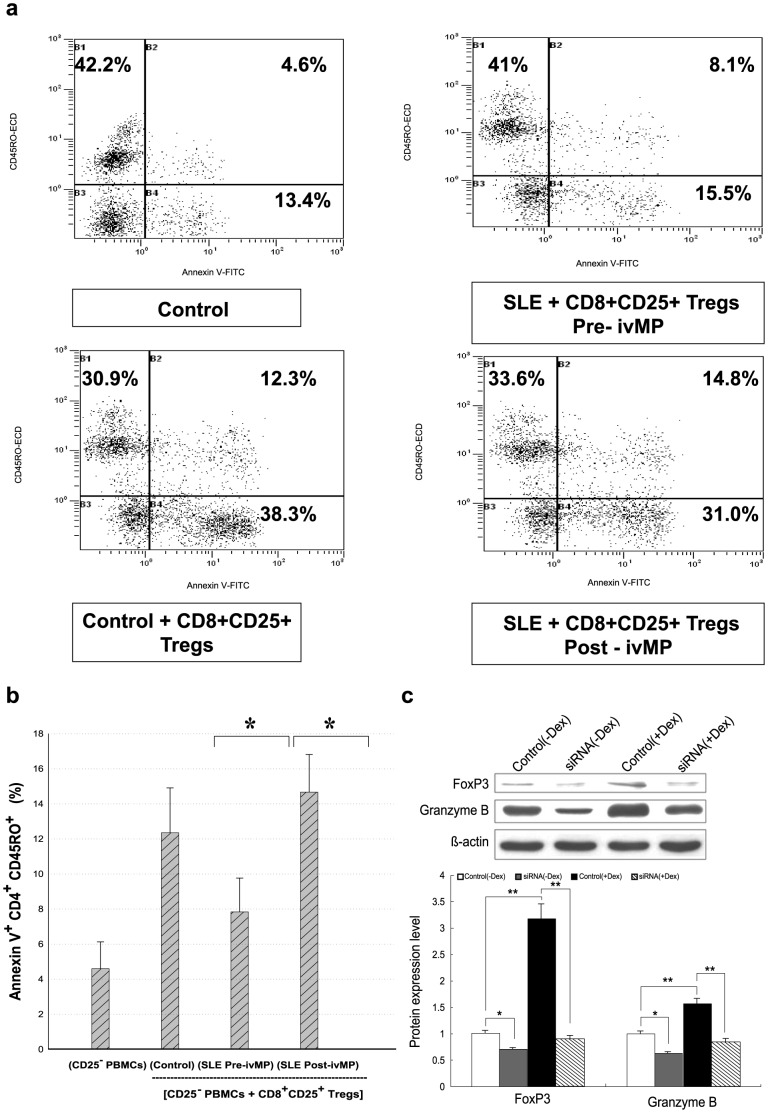
Double fluorescence study by flow cytometry of CD45RO lymphocytes subpopulations and apoptosis by CD8+CD25+ regulatory T cells during IVMP.(a). CD25+-depleted PBMCs were co-cultured with CD8+CD25+ Treg cells from control subjects or CD8+CD25+ Treg cells after IVMP during SLE. Apoptosis was simultaneously determined by Annexin V labeling and negative PI gating, representative histograms shown. (b). Percentage of Annexin V-positive CD4+CD45RO+ cells rose sharply after addition of Treg cells during IVMP, data calculated from 20 paired experiments. (*#
p<0.05). (c). siRNA of FoxP3 decreased granzyme B protein expression in CD8+CD25+ Treg cells if pretreated with nucleosomal histone peptide epitope (H3:115–135) and dexamethasme (50 nM). Right column shows control without dexamethasone, nucleosomal histone peptide epitope and siRNA treatment; left column second control pretreated with nucleosomal histone peptide epitope with IL-2 (10 U/ml) for 3 days and third day treated with dexamethasone for 24 hours. Middle left column was a control RNA transfection for FoxP3 siRNA. Middle right column was pretreated with nucleosomal histone peptide for 3 days and third day treated with dexamethasone for 24 hours their FoxP3 siRNA treatment for 48 hours. Data were derived from three independent experiments; bars represent mean±SD.